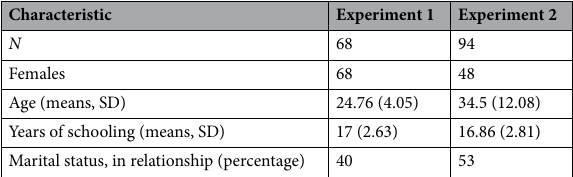
Table 1. Demographic characteristics. SD standard